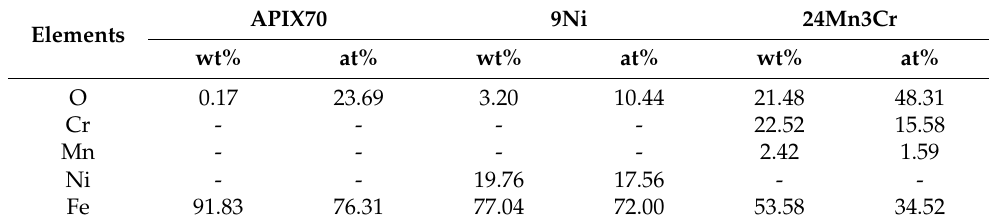
Table 4. EDS quantitative analysis at each point marked on Figure 5.